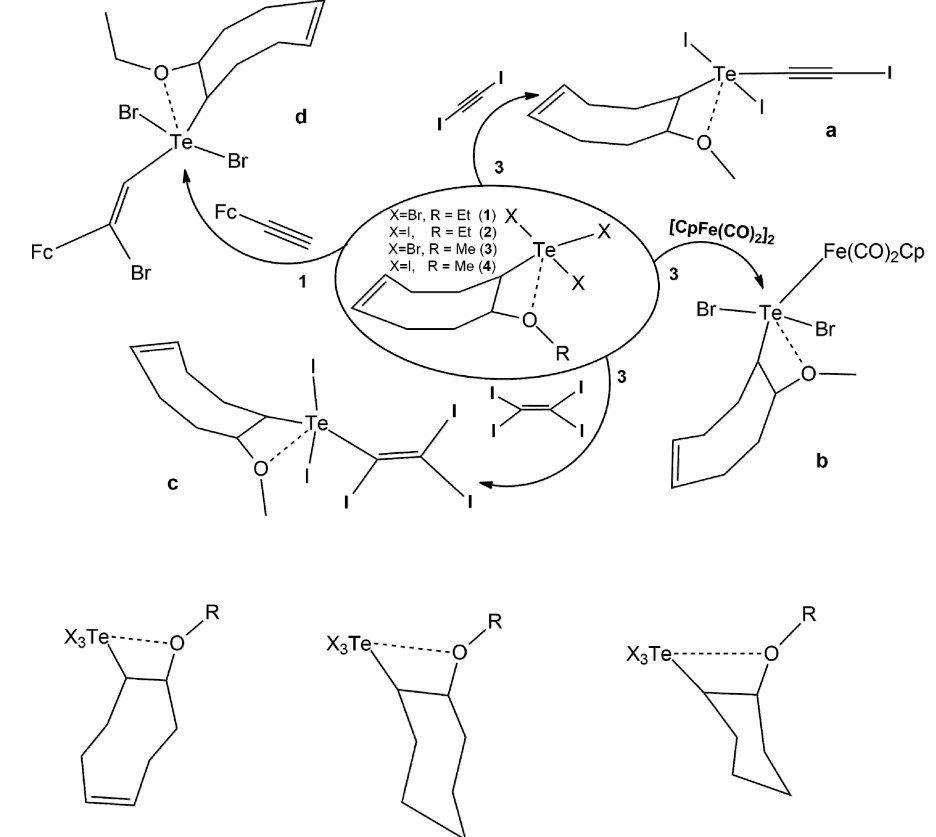
Scheme 1. Interaction of cyclo-C 8 H 12 (OR)TeX 3 with ( a ) diiodo-ethyne C 2 I 2 ; ( b ) [CpFe(CO) 2 ] 2 ; ( c ) tetraiodo-ethene C 2 I 4 ; ( d ) ferrocenyl-ethyne FcC 2 H.